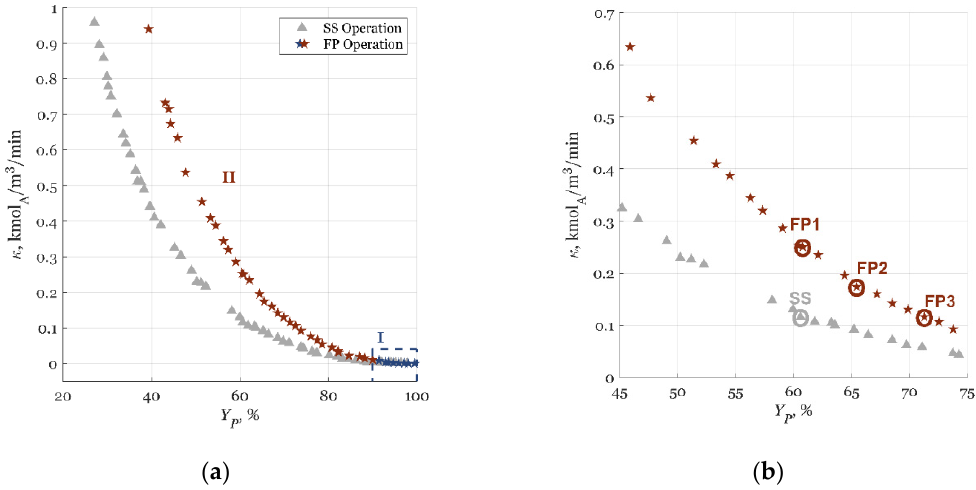
Figure 3. Product yield (BI1) and reactor volumetric capacity (BI2 / CI) in Pareto fronts for CSTR example: